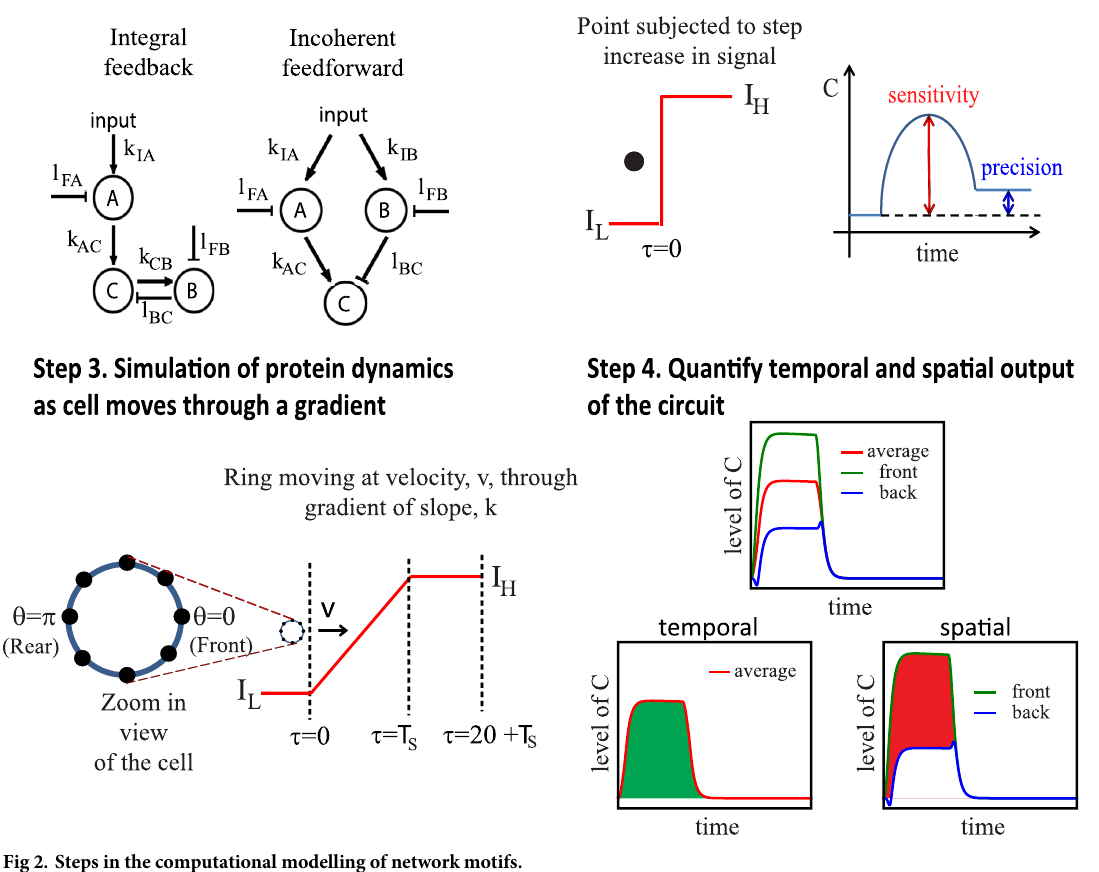
repressor protein (protein B ) diffuses faster than protein A ) and the diffusibility of the output protein (protein C ) is low. In all other cases, temporal sensing performs better. By incorpo- rating noise into our analysis, we also found that temporal sensing is more robust to noise than spatial sensing.